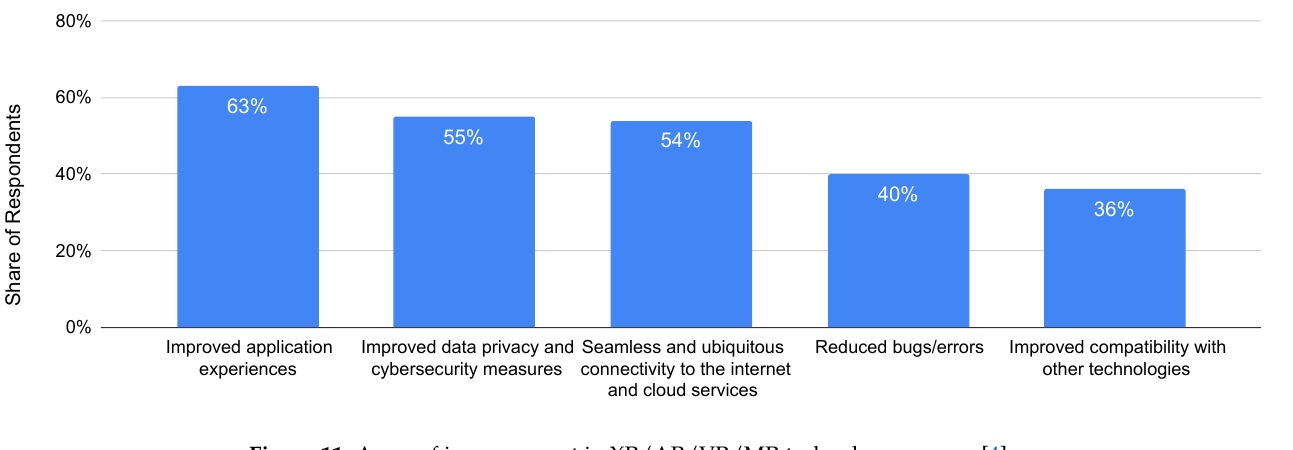
Figure 11. Areas of improvement in XR/AR/VR/MR technology, source: